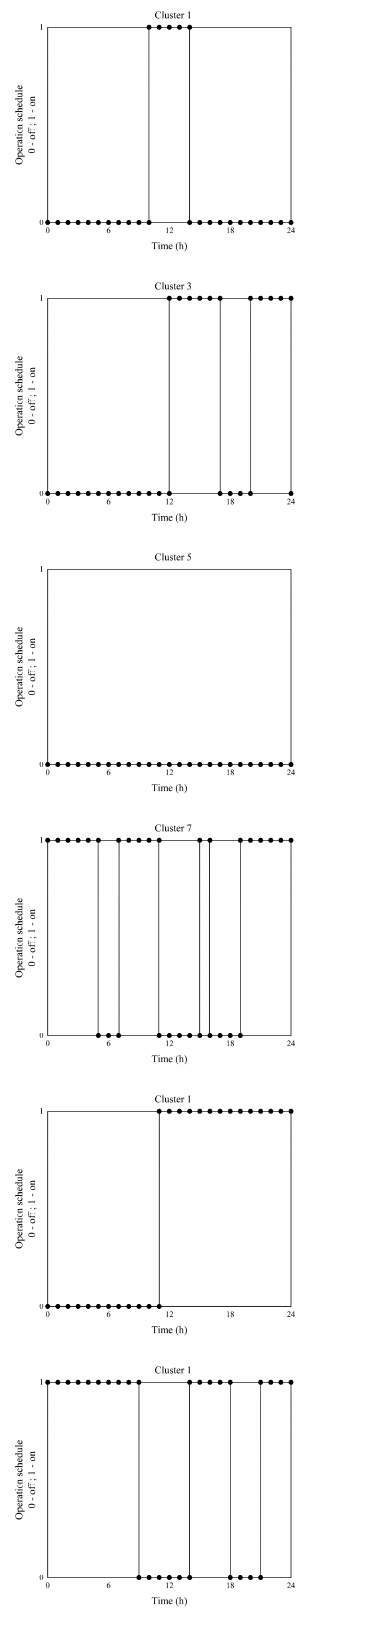
Figure 10. AAHP heating pattern schedules for different heating periods in Shandong’s living